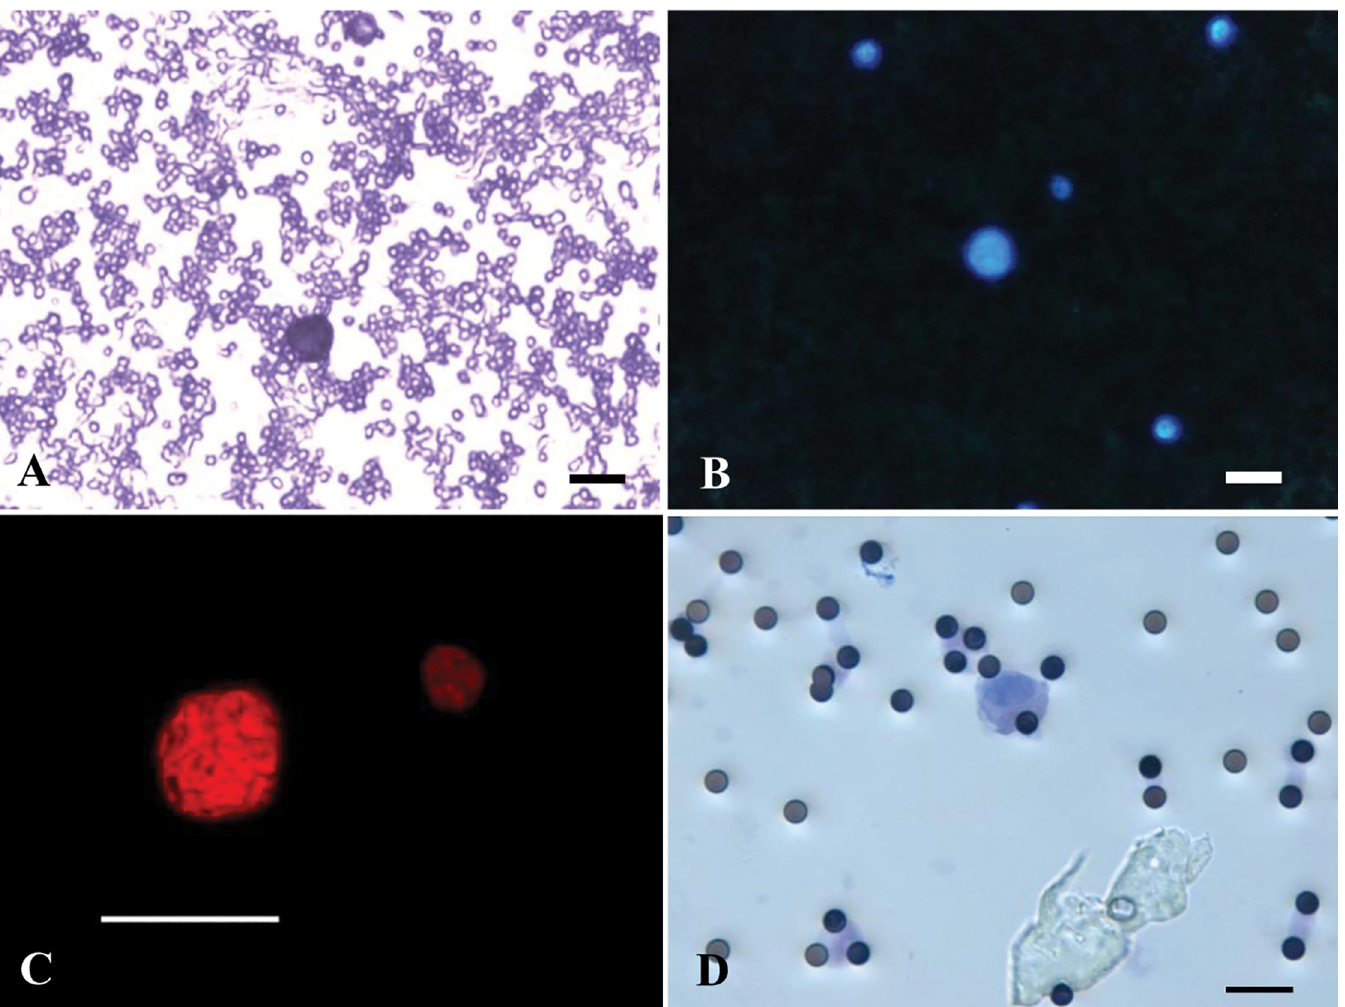
Fig 1. Suspicious circulating elements in SQCLC patients. Representative image of a suspicious circulating element (SCE) isolated by depletion procedure and stained by hematoxylin; contaminant platelets and red blood cell ghosts are present in the background (A). DAPI stained SCE nucleus and small contaminant white blood cells (B). Confocal image of a large hyperchromatic SCE nucleus labelled by the red fluorescence of propidium iodide (PI); a small PI stained nucleus of a white blood cell is also present (C). Weak hematoxylin and eosin stained nucleus of a SCE isolated by the ScreenCell device. Black round dots correspond to 8 μ m pores of the filter (D). Scale bars A, B, C, D = 20 μ m.